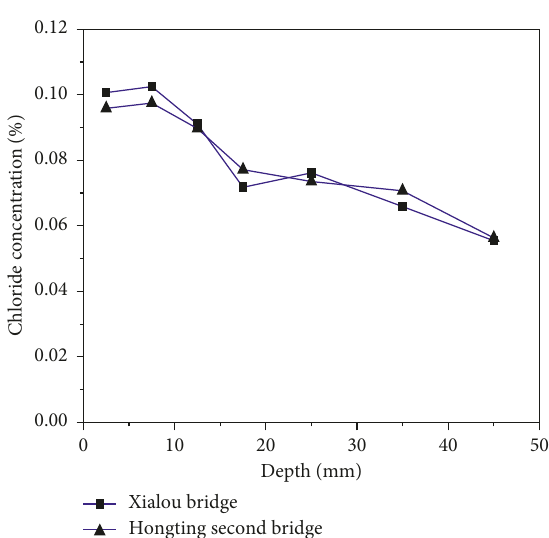
Figure 15: Comparison of chloride profile between Hongting Second bridge and Xialou